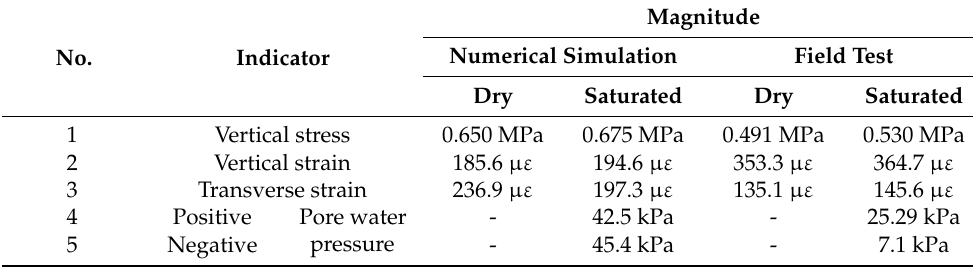
Table 4. Comparison of responses obtained from numerical simulation and field